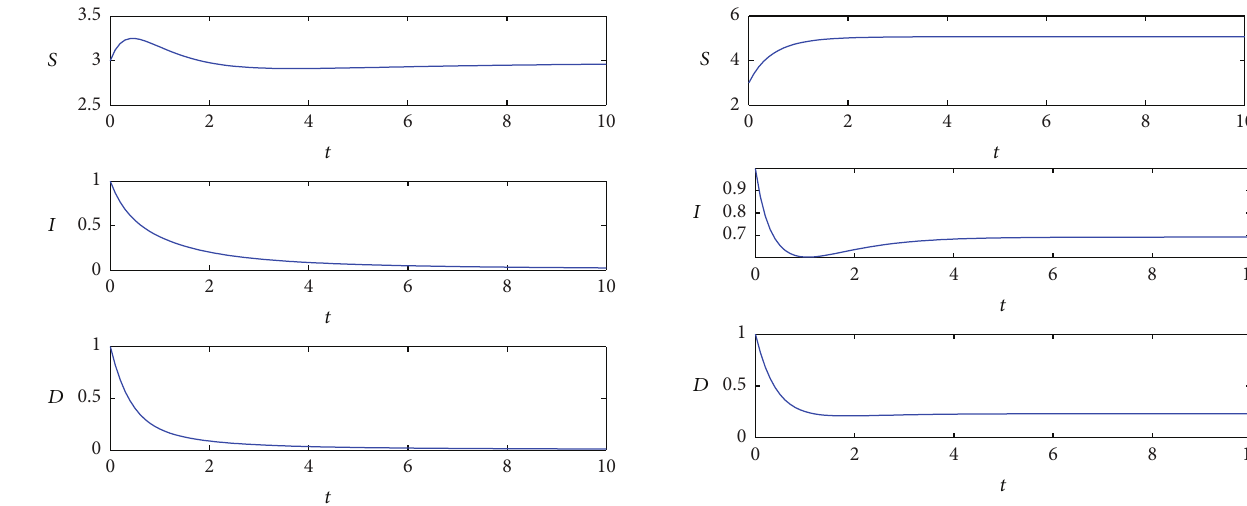
Figure 3: Taking the initial value (3, 1, 1) and 𝜏 = 0 , 𝑏 = 6 , 𝛼 = 𝑑 = 𝑘 = 𝑐 = 𝑢 = 1 , and the 0 and the solution (𝑆(𝑡),𝐼(𝑡), 𝐷(𝑡)) tends to the endemic equilibrium = (5.0769, 0.6923, 0.2308) as 𝑡 → ∞ 𝐸 ∗